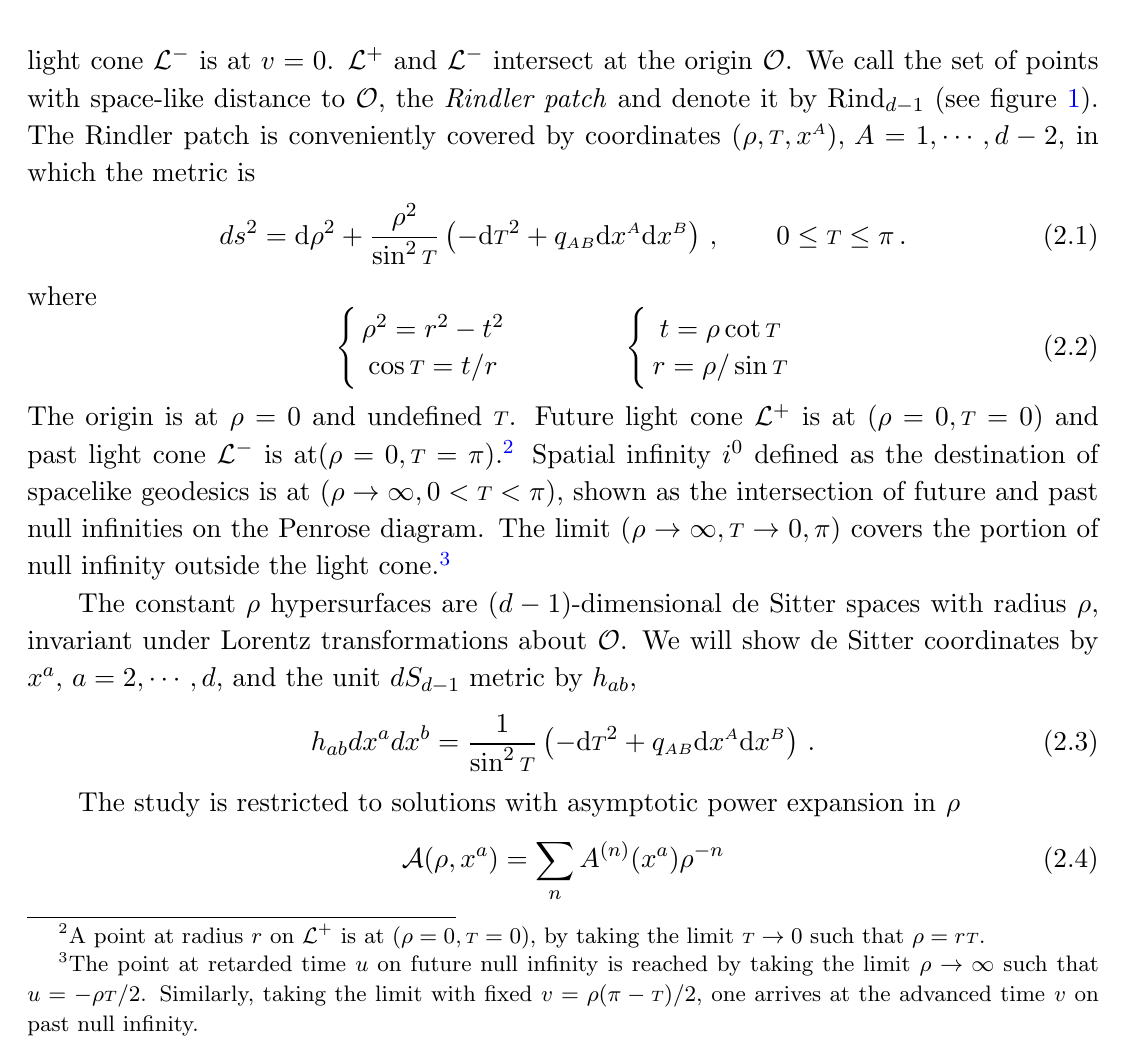
Figure 1 . Penrose diagrams of Minkowski (cid:13)at spacetime M d . The Rindler patch covers the events outside the light cone. The solid lines are constant T slices, while dotted lines are constant (cid:26)